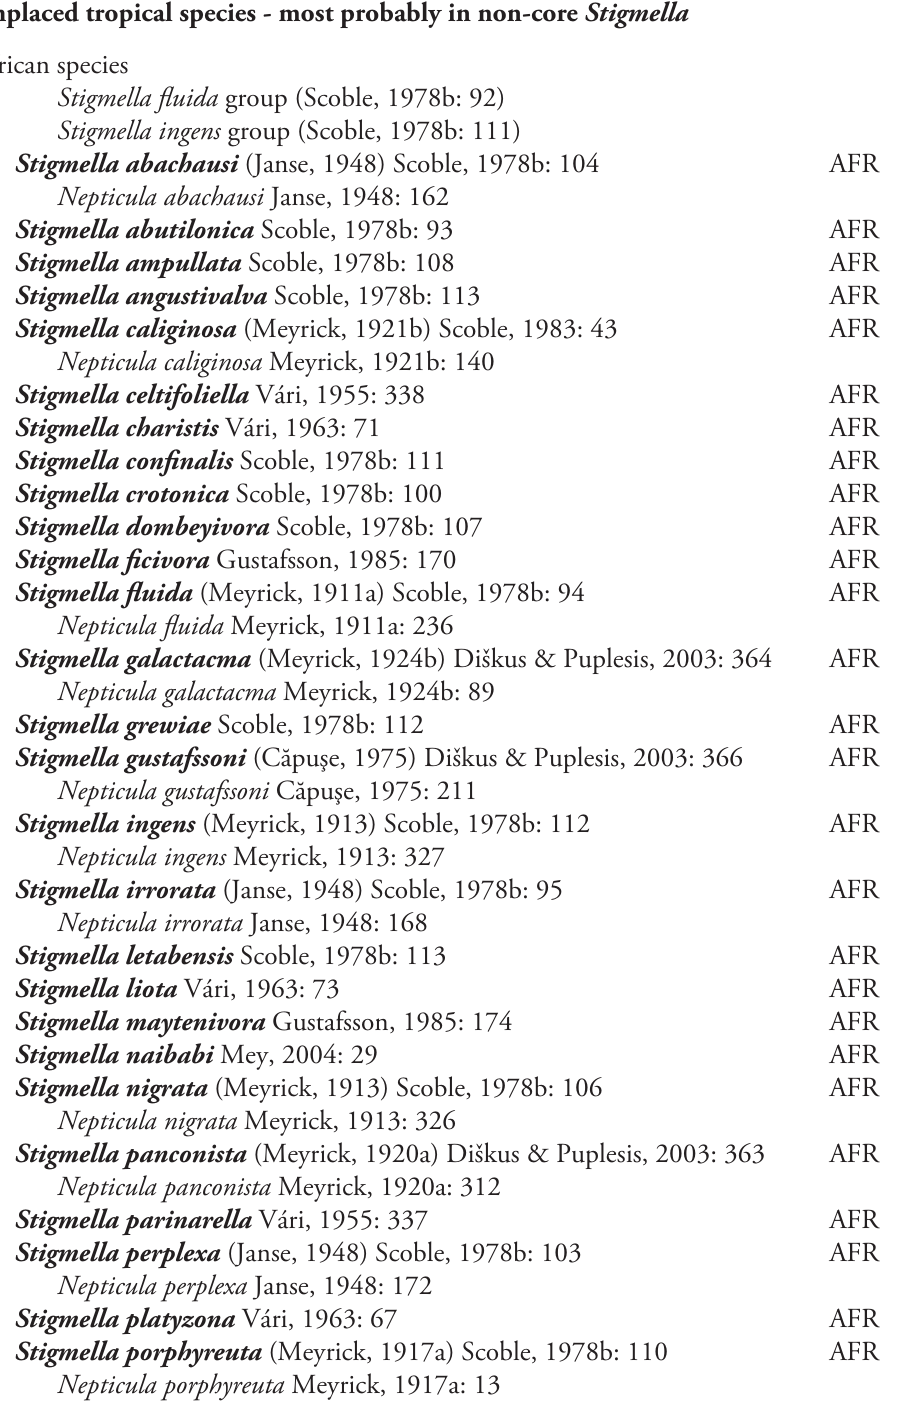
Stigmella charistis Vári, 1963: 71 AFR Stigmella confinalis Scoble, 1978b: 111 AFR Stigmella crotonica Scoble, 1978b: 100 AFR Stigmella dombeyivora Scoble, 1978b: 107 AFR Stigmella ficivora Gustafsson, 1985: 170 AFR Stigmella fluida (Meyrick, 1911a) Scoble, 1978b: 94 AFR Stigmella liota Vári, 1963: 73 AFR Stigmella maytenivora Gustafsson, 1985: 174 AFR Stigmella naibabi Mey, 2004: 29 AFR Stigmella nigrata (Meyrick, 1913) Scoble, 1978b: 106 AFR Stigmella panconista (Meyrick, 1920a) Diškus & Puplesis, 2003: 363 AFR Stigmella parinarella Vári, 1955: 337 AFR Stigmella platyzona Vári, 1963: 67 AFR Stigmella porphyreuta (Meyrick, 1917a) Scoble, 1978b: 110